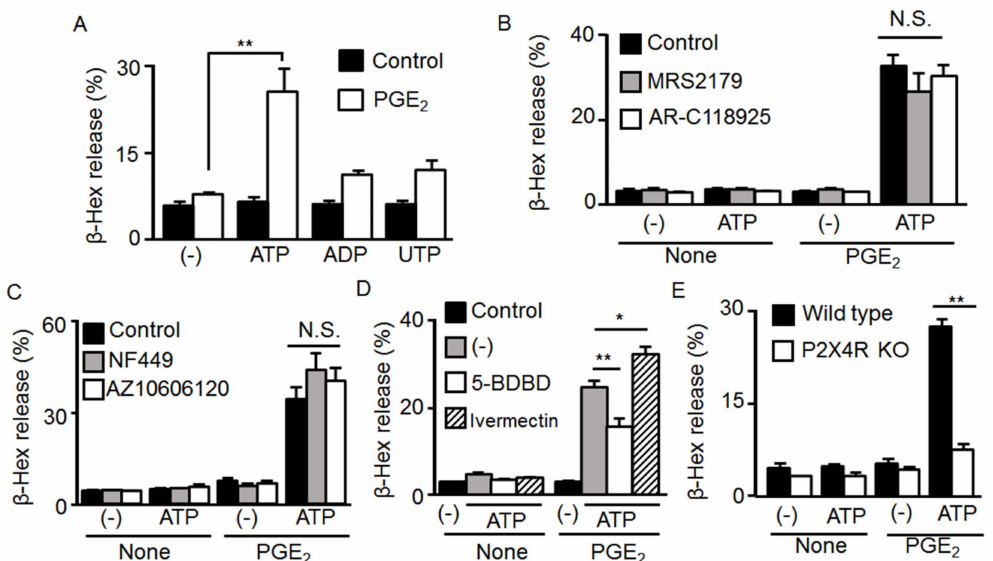
Figure 3. Involvement of P2X4 receptor (P2X4R) activation in the synergistic e ff ect of